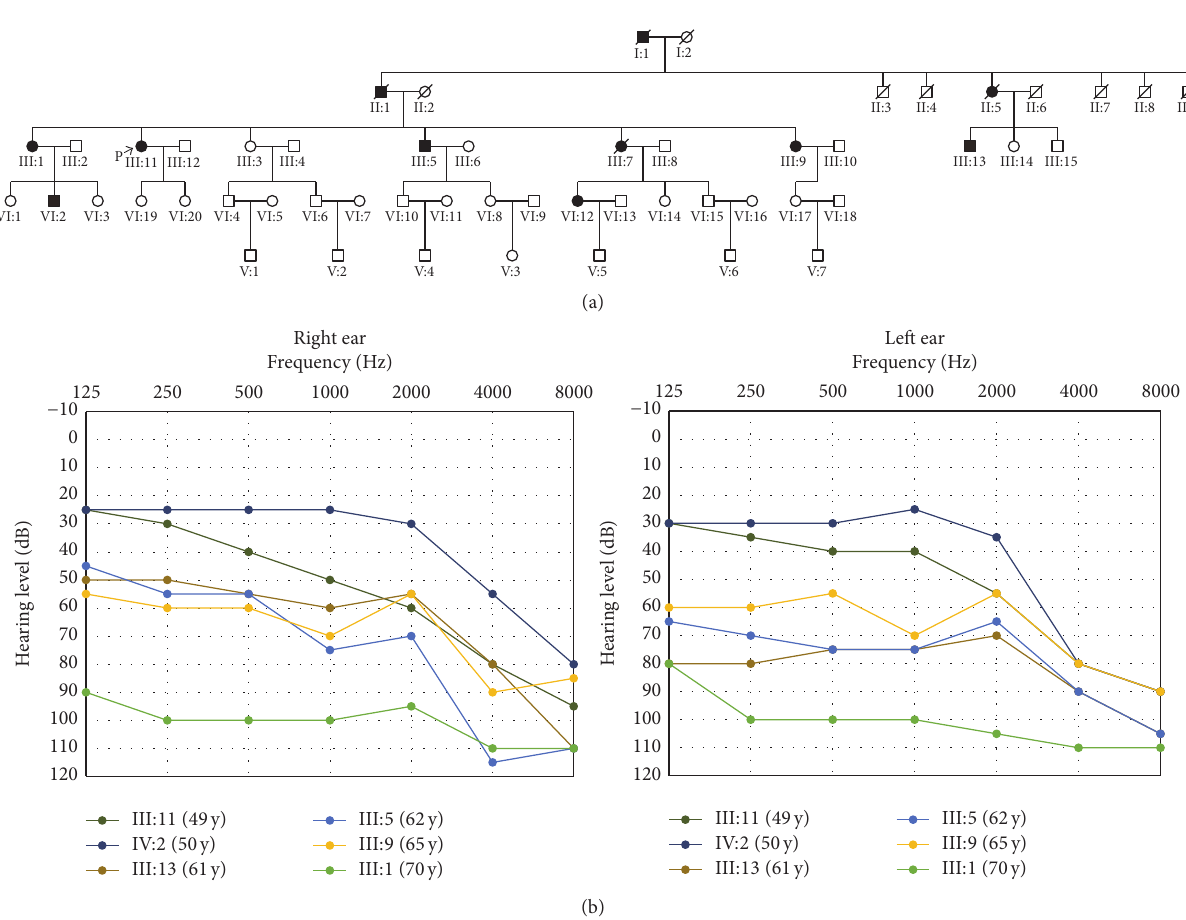
Figure 1: (a) Pedigree of the family with nonsyndromic autosomal recessive hearing loss. Darkened symbols denote affected individuals. (b) Audiograms of all affected individuals in the